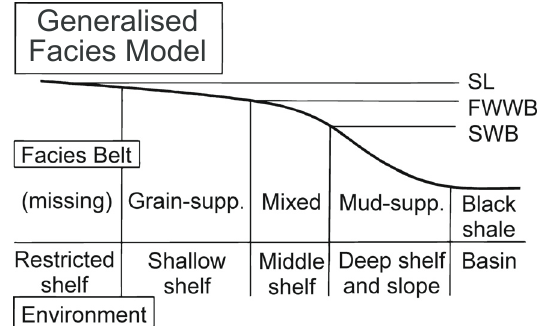
Fig. 2. Facies model of the Upper Ordovician of Estonia (after Harris et al. 2004). Abbreviations : SL – sea level, FWWB – fair- weather wave-base, SWB – storm wave-base, supp. –